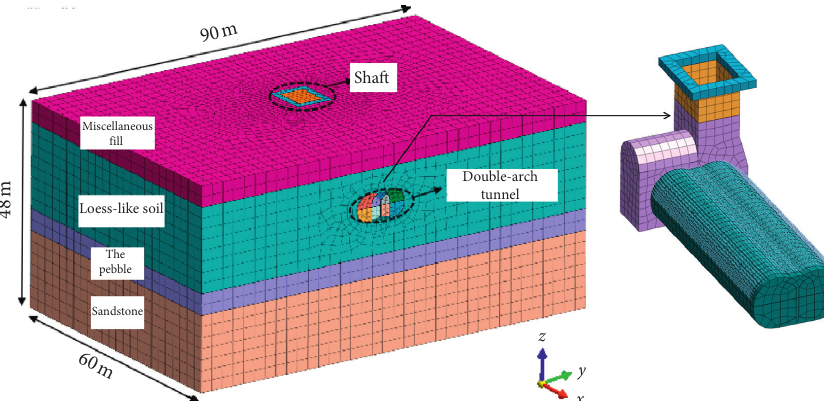
Figure 7: Calculation model.